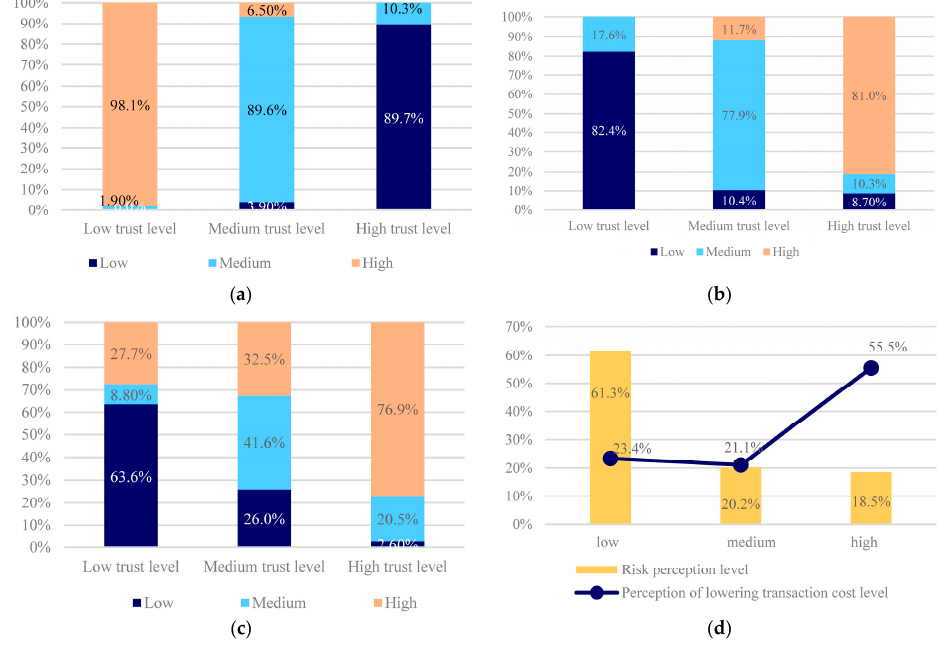
Figure 4. Trust, risk perception, possibility of transaction cost reduction, and willingness to supply straw. ( a ) Trust level and risk perception; ( b ) Trust level and possiblity of reducing transaction cost; ( c ) Trust level and farmers’ willingess to supply straw; ( d ) Risk perception, and possibility of reduced transaction cost.